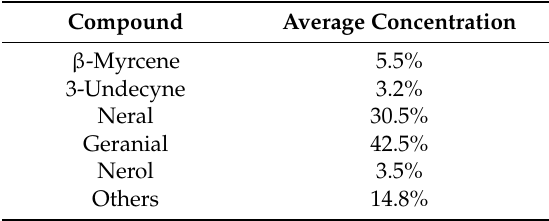
Table 1. Chemical composition of lemongrass dry